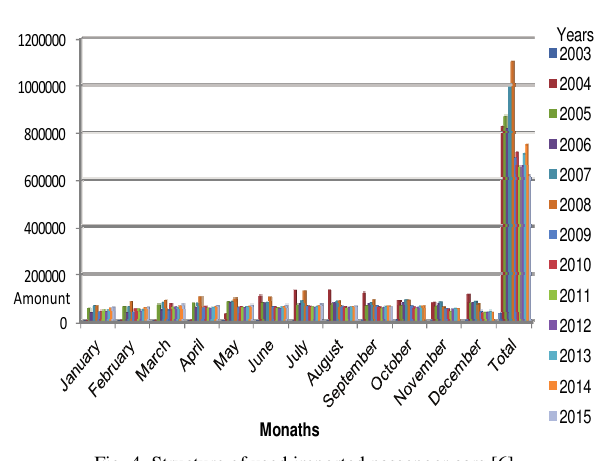
Fig. 3. Registered vehicles 2015 [8]